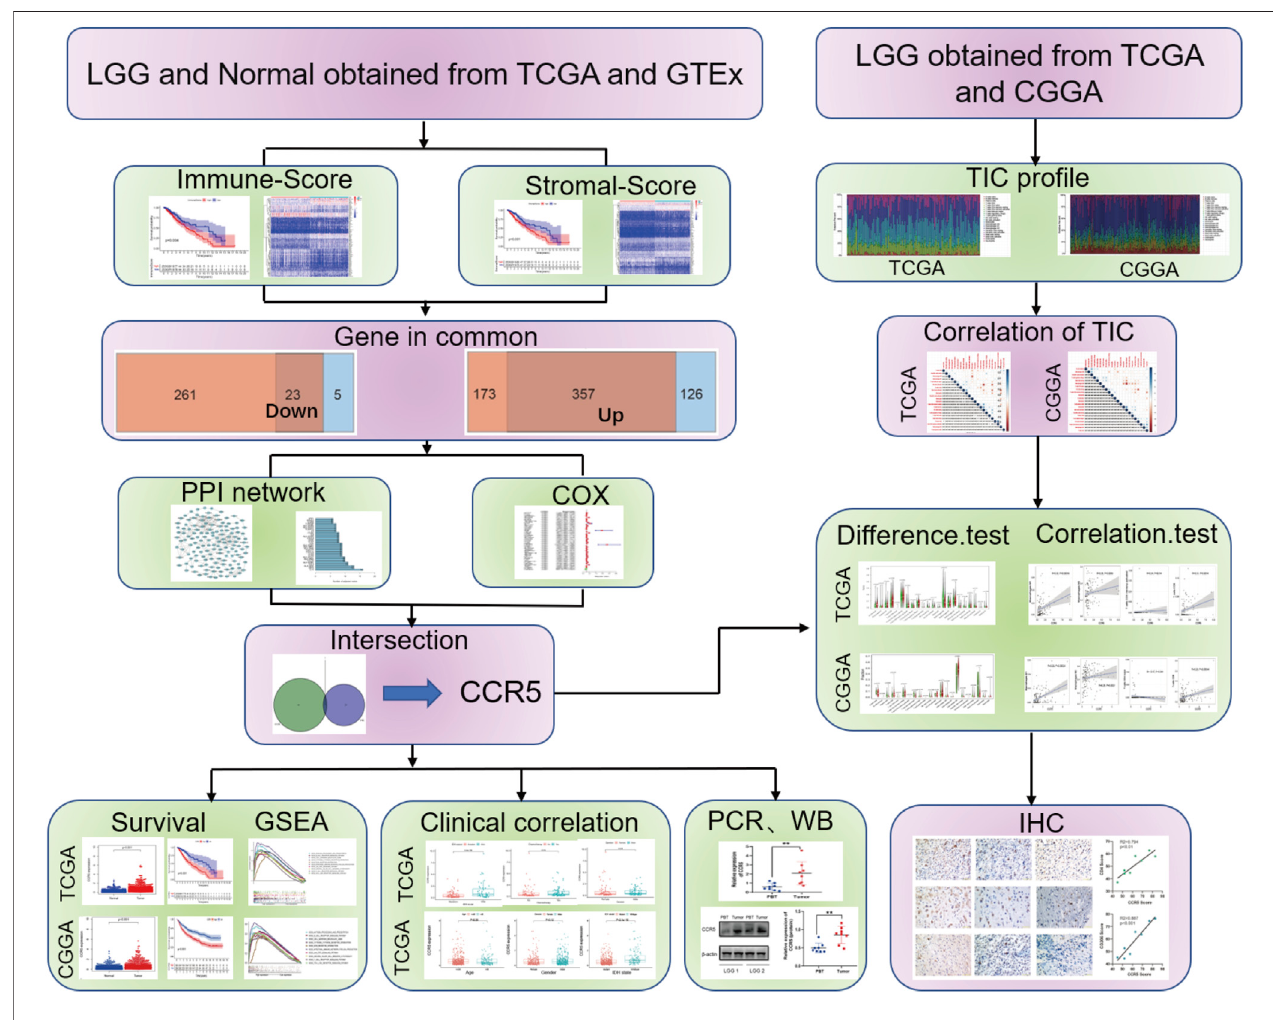
FIGURE 1 | Analysis work fl ow of this study.